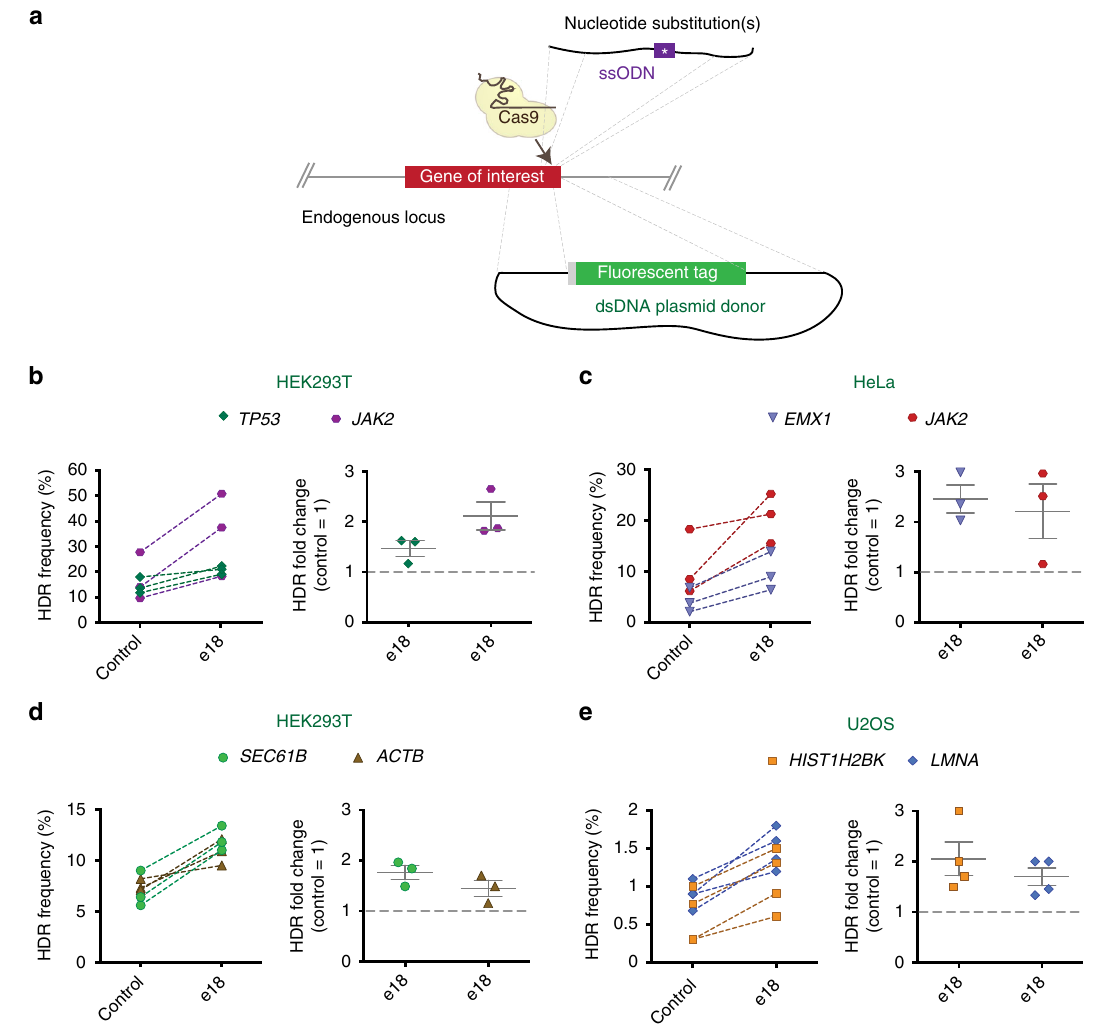
Fig. 5 Targeting of endogenous loci in human cells using e18. a Schematics of the gene targeting experiments conducted using either ssODNs carrying nucleotide substitutions or dsDNA donor plasmids with fl uorescent tags. b , c Gene targeting ef fi ciency at the TP53 (green) and JAK2 (purple) loci in HEK293T cells ( b ) and the EMX1 (blue) and JAK2 (red) loci in HeLa cells ( c ) upon transfection of TP53 , JAK2 , or EMX1 ssODN template, Cas9 and sgRNA expression vectors, and either a plasmid expressing e18 or an empty vector control. Gene targeting ef fi ciency at the TP53 locus was determined by NGS, while gene targeting ef fi ciency at the JAK2 and EMX1 loci was estimated by RFLP assay. HDR frequency values of individual paired experimental sets are shown on the left graph. Fold change in HDR values for e18-expressing conditions relative to the control (dashed line) are shown on the right graph, where individual experiments are presented along with the mean ± s.e.m. ( n = 3). d Gene targeting ef fi ciency at the SEC61B (green) and ACTB (brown) loci in HEK293T cells transfected with either SEC61B-GFP or ACTB-GFP donor template, Cas9 and sgRNA expression vectors, and either a plasmid expressing e18 or an empty vector control, as determined by fl ow cytometry analysis of GFP + cells. Experiments are represented as in b (n = 3). e Gene targeting ef fi ciency at the HIST1H2BK (yellow) and LMNA (blue) loci in U2OS cells transfected with either HIST1H2BK-mAG or ACTB-Clover donor template, sgRNA and Cas9 expression vectors, and a plasmid expressing e18 or an empty vector control, as determined by fl ow cytometry analysis of mAG + or Clover + cells. Experiments are represented as in b ( n = 4). The full list of HDR values for all the gene editing experiments at endogenous loci is available in Supplementary Data 3. Source data are available in the Source Data fi